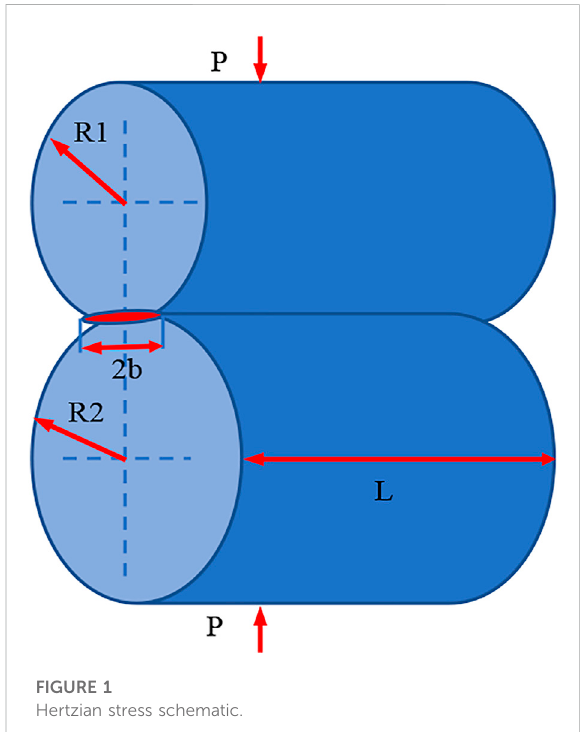
FIGURE 1 Hertzian stress schematic.